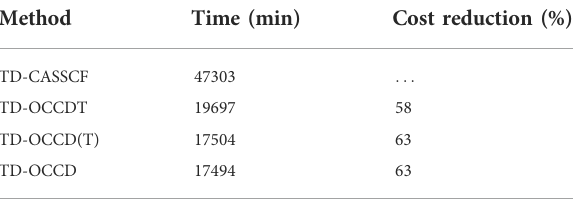
TABLE 2 Comparison of the total simulation time a (in min) spent for TD-CASSCF, TD-OCCDT, TDCCD(T), and TD-OCCD methods.